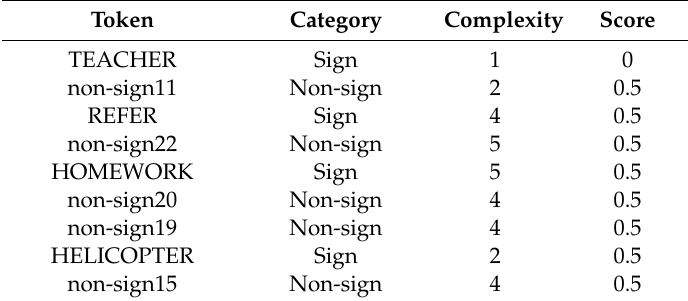
Table 2. Gregory’s (only) errors on the sign and non-sign copy